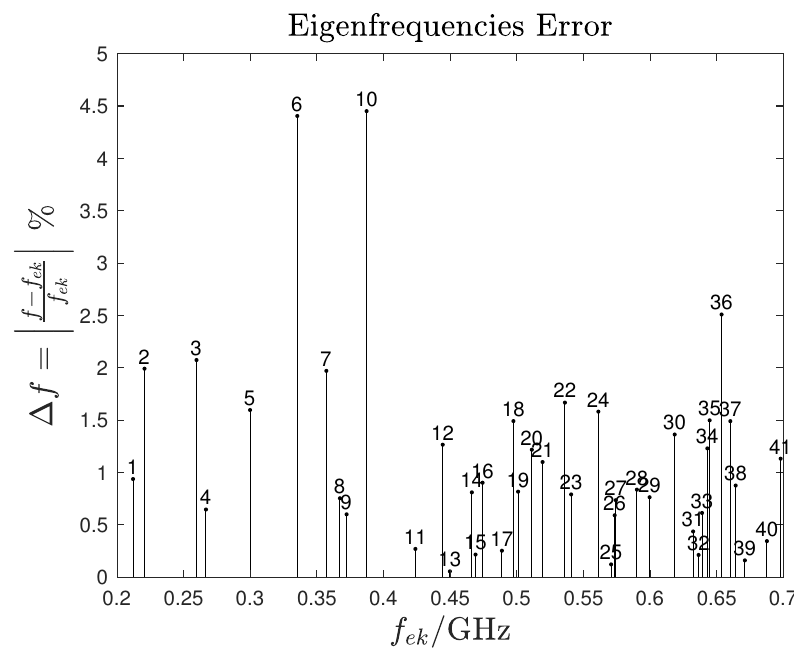
Figure 9. Eigenfrequencies error. Each stem corresponds to the numerical eigenfrequency f ek